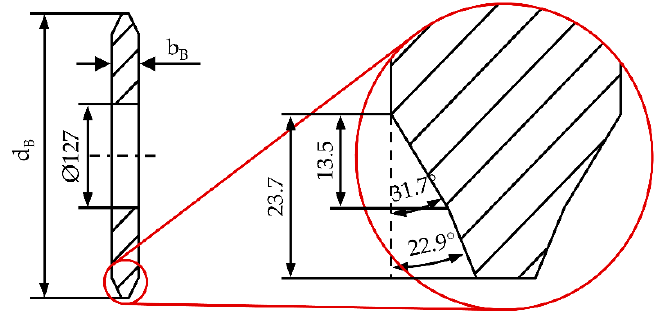
Figure 3. Design drawing for the profiling of the brushing tools according to the gear gap. Table 3. Specification parameters of the brushing